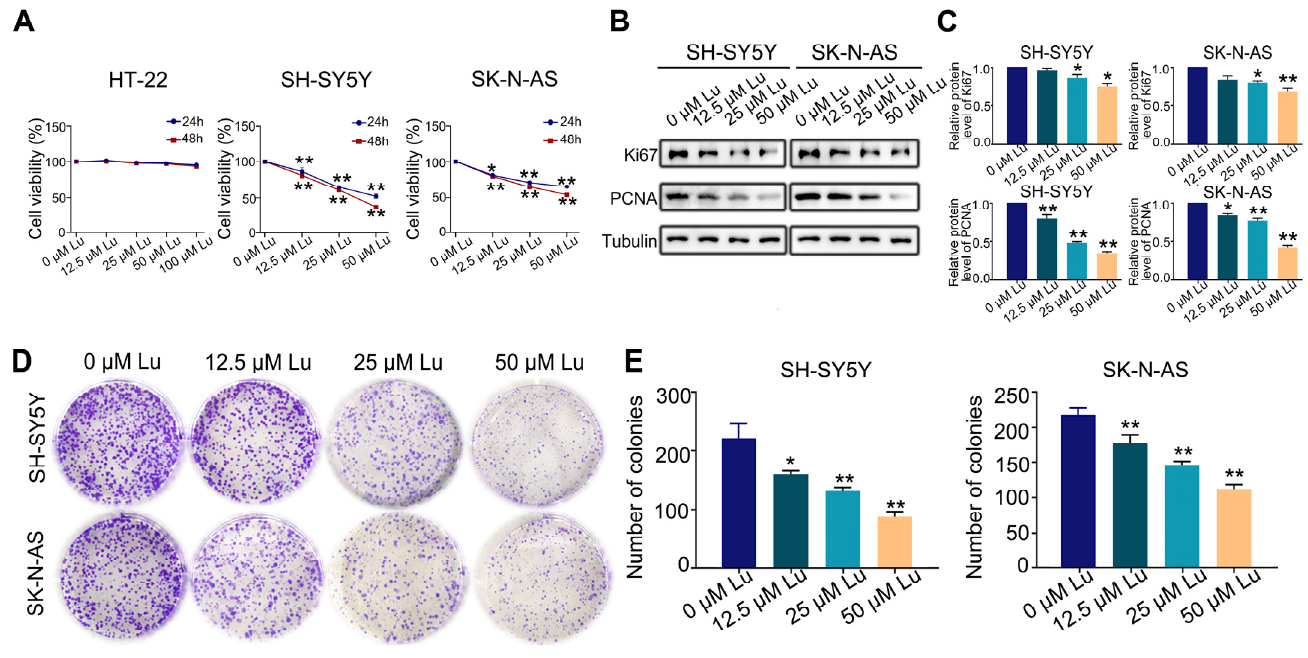
Figure 1. Luteoloside inhibits the proliferation of neuroblastoma cells. SH-SY5Y and SK-N-AS cells were treated with varying concentrations (0, 12.5, 25, and 50 µ M) of luteoloside for 24 or 48 h, while HT-22 was treated with different concentrations (0, 12.5, 25, 50, and 100 µ M) of luteoloside for the same periods. ( A ) The viability of HT-22, SH-SY5Y, and SK-N-AS cells was detected in each group. ( B ) The expression of PCNA and Ki67 was tested by Western blot. ( C ) Statistical analysis of the expressions intensity of PCNA, Ki67 in SH-SY5Y and SK-N-AS cells. Tubulin is taken as internal reference. ( D ) The colony formation of SH-SY5Y and SK-N-AS cells was tested in each group. ( E ) Statistical analysis of the number of colonies in each group. *, p < 0.05; **, p < 0.01. n = 3. The control group is used for comparison. Data are shown as mean ± SD.